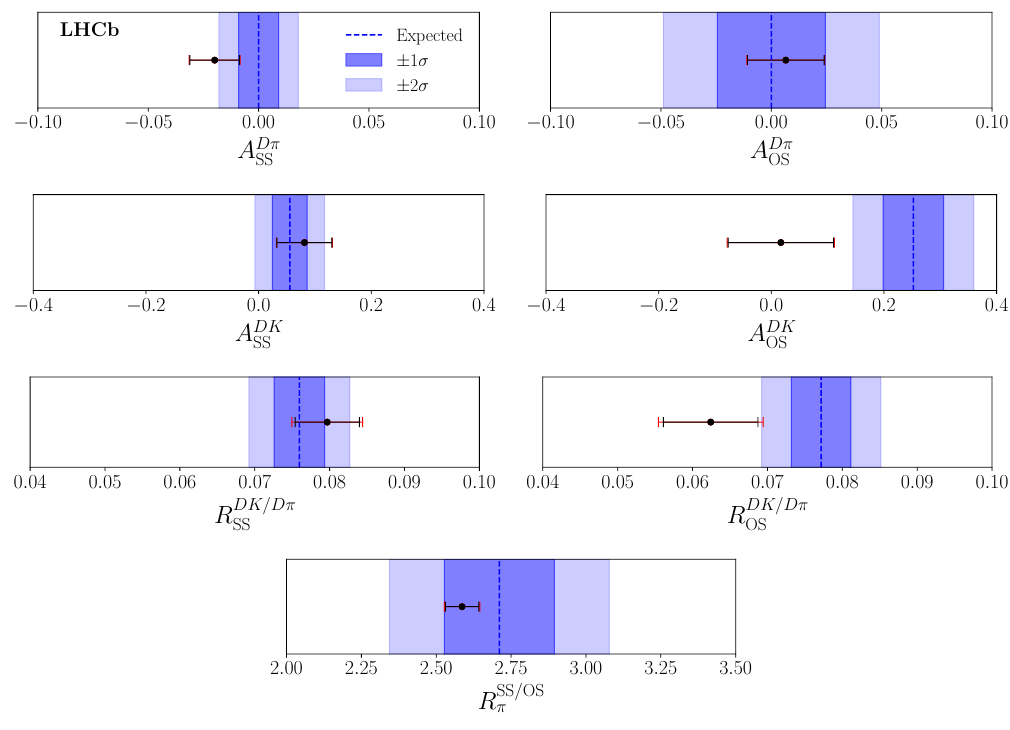
Figure 6 . Comparison with SM expectations for results within the K (cid:3) + region, using current world-average parameter values. The dashed blue line indicates the expected SM value, and the shaded dark (light) blue regions indicate the 68% (95%) con(cid:12)dence-level intervals. The results are shown as black points with black (red) error bars indicating the statistical (total)